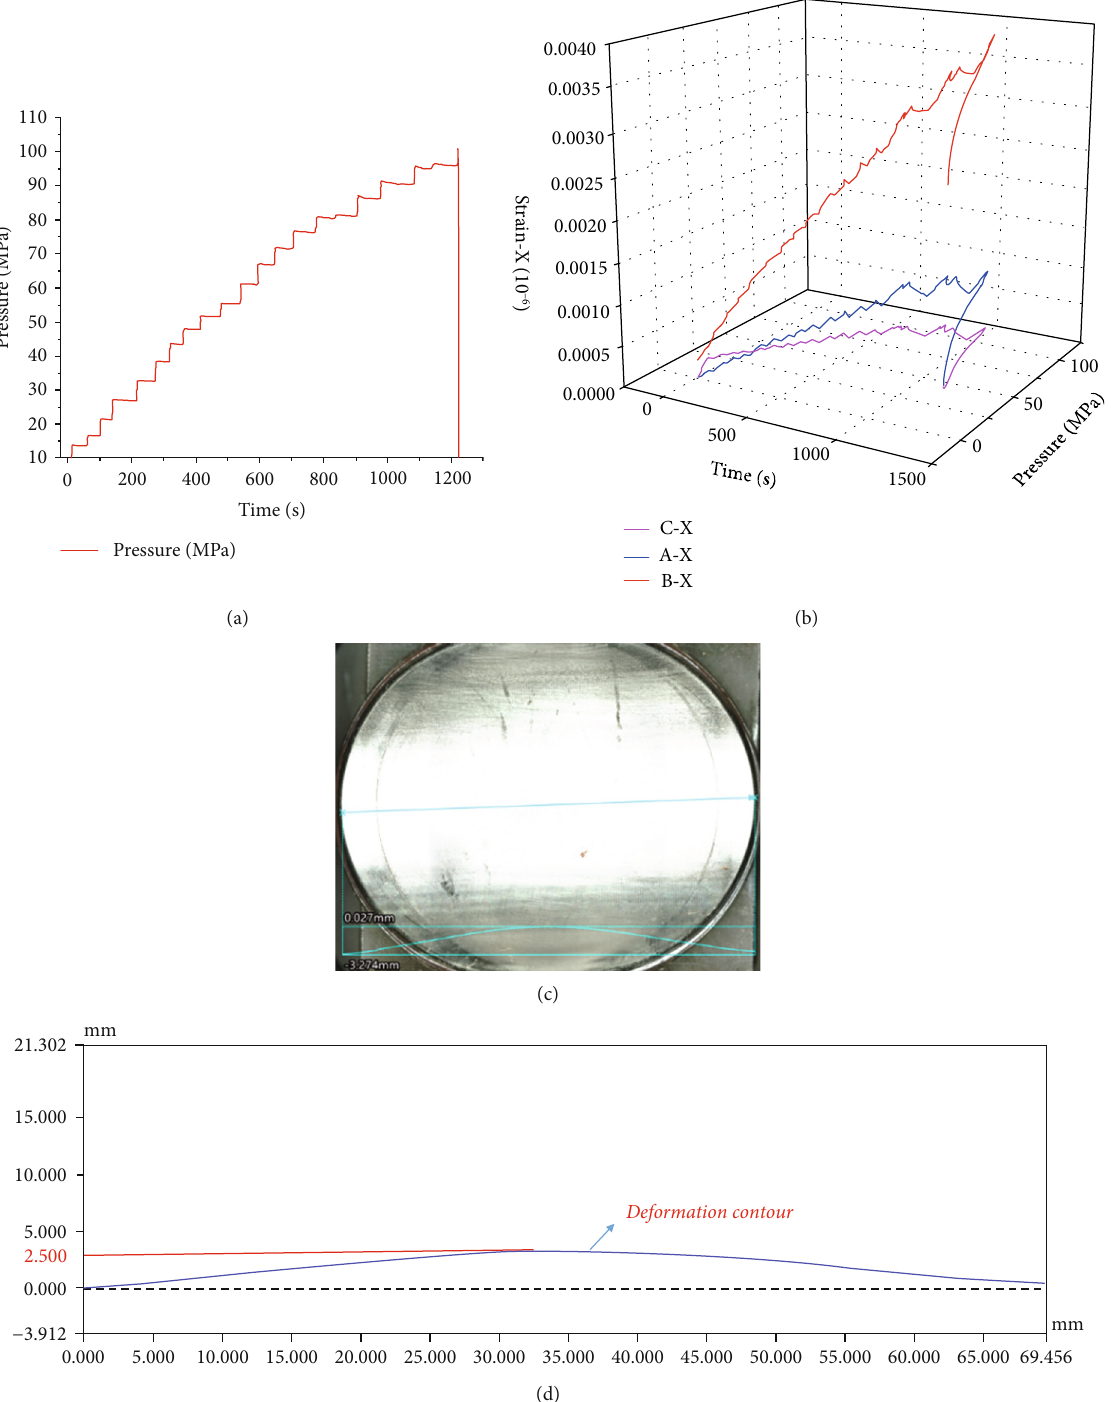
Figure 16: Test result. (a) Failure pressure loading curve. (b) Multipoint strain curve for the valve cover. (c) Contour scanning of the valve cover. (d) Contour curve of the valve cover